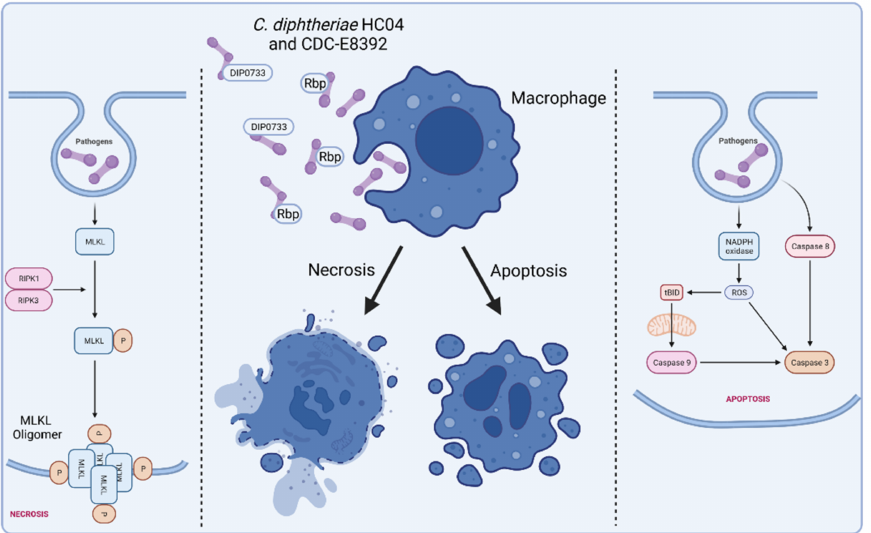
Figure 6. C. diphtheriae -induced necrosis and apoptosis in macrophages. Infection of